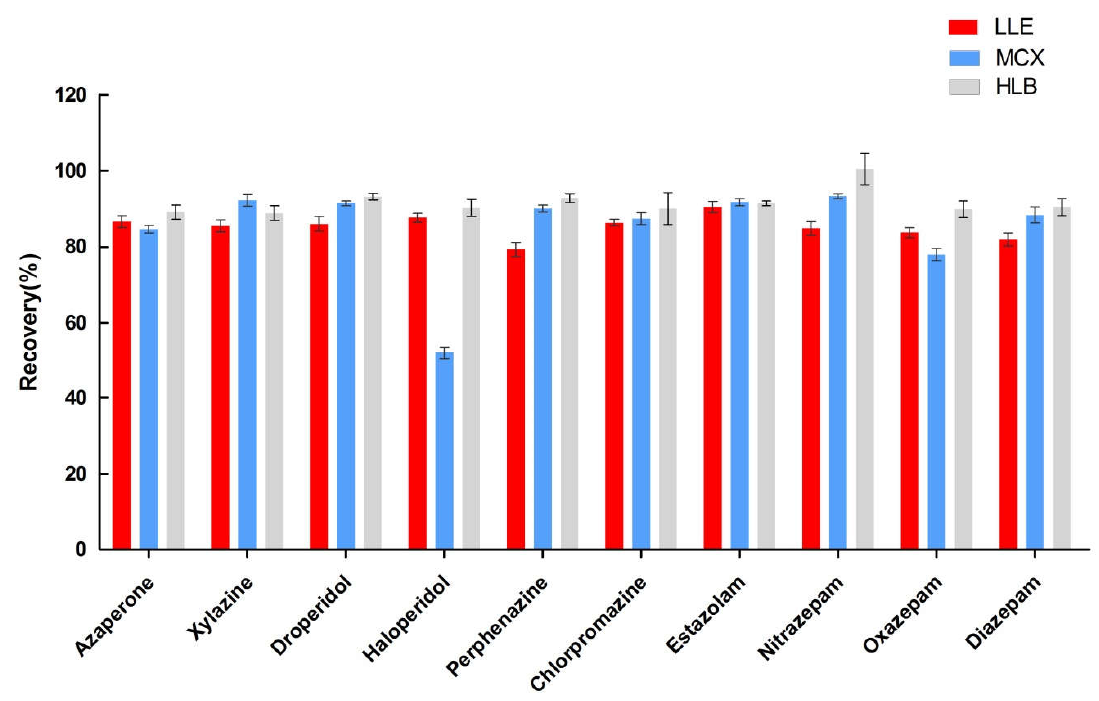
Figure 2. Recoveries of liquid-liquid extraction (LLE) and solid-phase extraction (SPE).